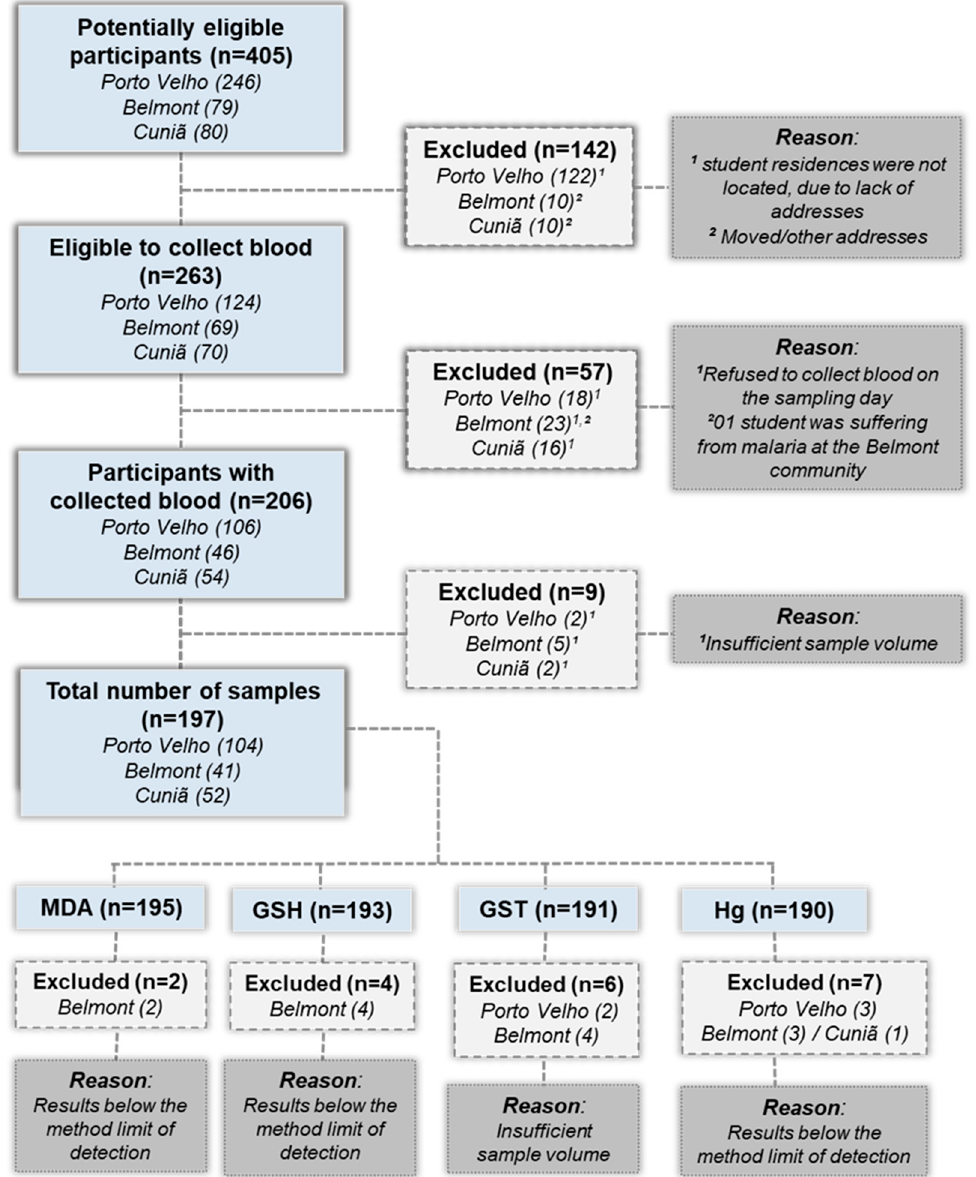
Figure 2. Flow diagram displaying the selection of the study population (children and adolescents, between 5 and 17 years old) in the Madeira basin, Rondônia/Brazil.